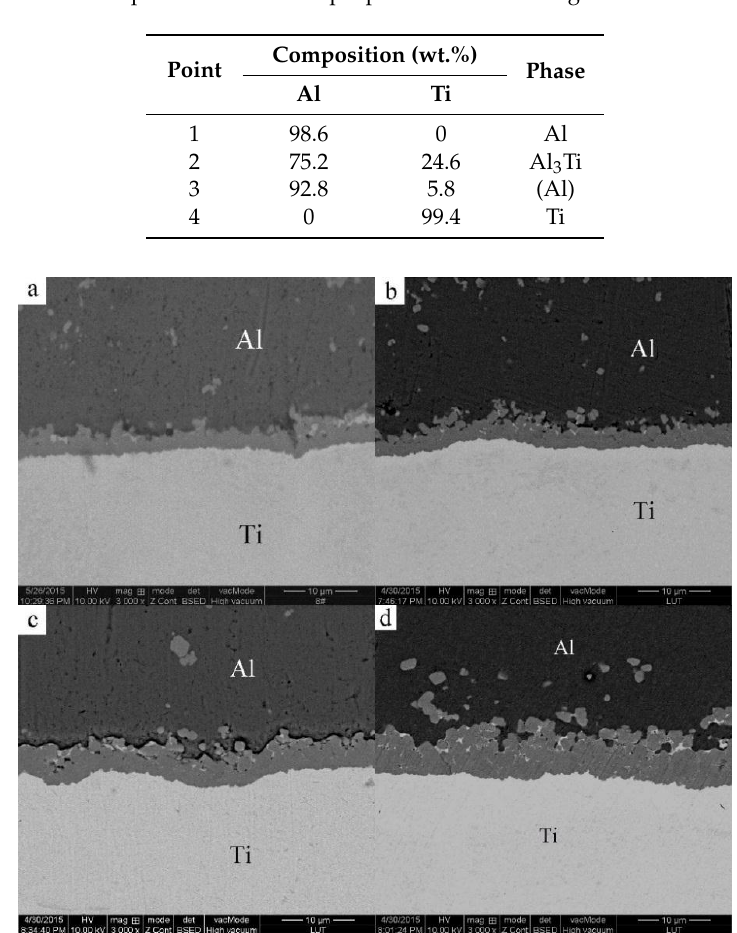
Figure 14. SEM micrographs of the Al-Ti interface after heating at 640 °C for different lengths of time: ( a ) 1 h; ( b ) 2 h; ( c ) 3 h; ( d ) 5 h; ( e ) 8 h; ( f ) 15 h. Figure 15. SEM micrographs of the Al-Ti liquid-solid interface after heating at 640 °C for 1 h and then etching by the Keller solution.